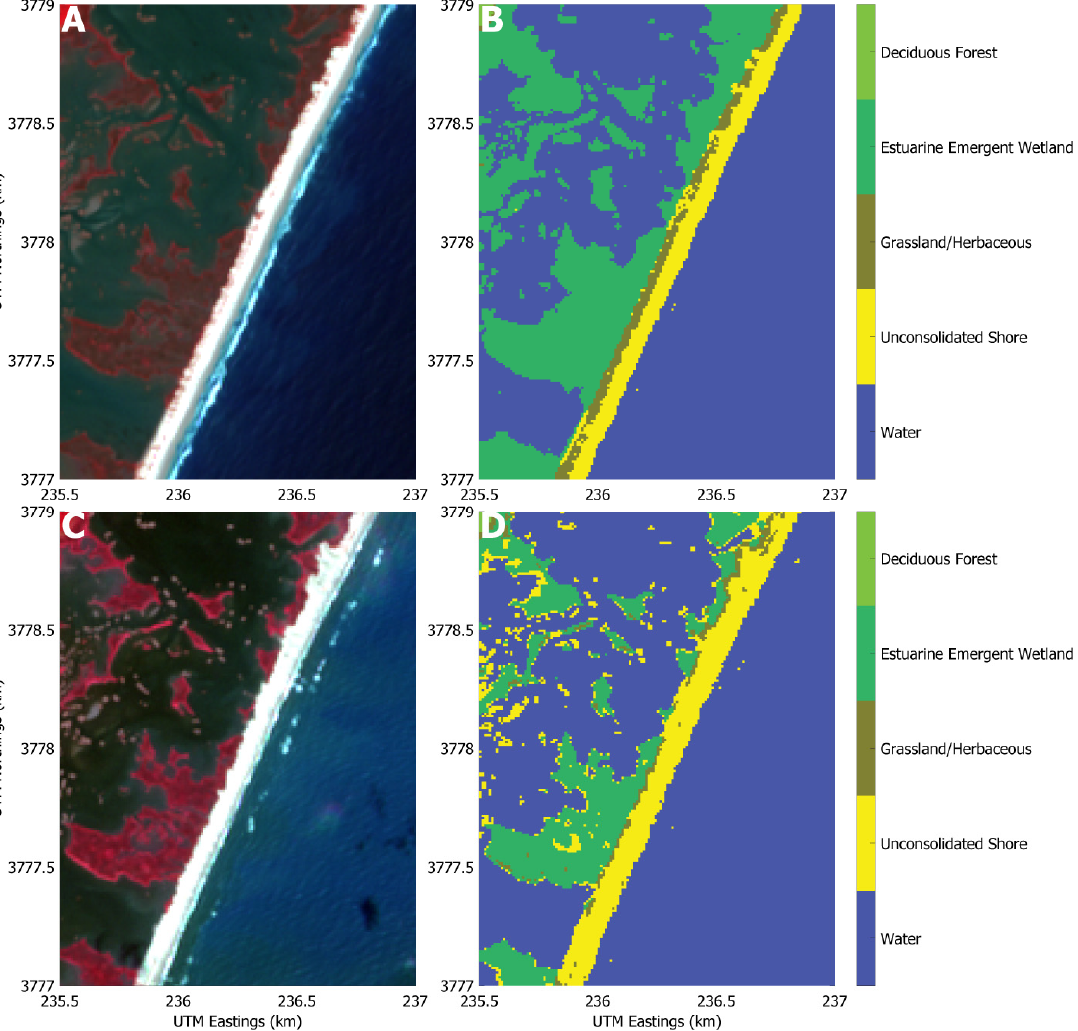
Figure 10. Pre-Florence (8 September 2018) Sentinel-2 imagery ( A ) and resulting land cover classification ( B ) and post- Florence (18 September 2018) Sentinel-2 imagery ( C ) and resulting land cover classification ( D ) for a portion of the southern section of Masonboro Island.